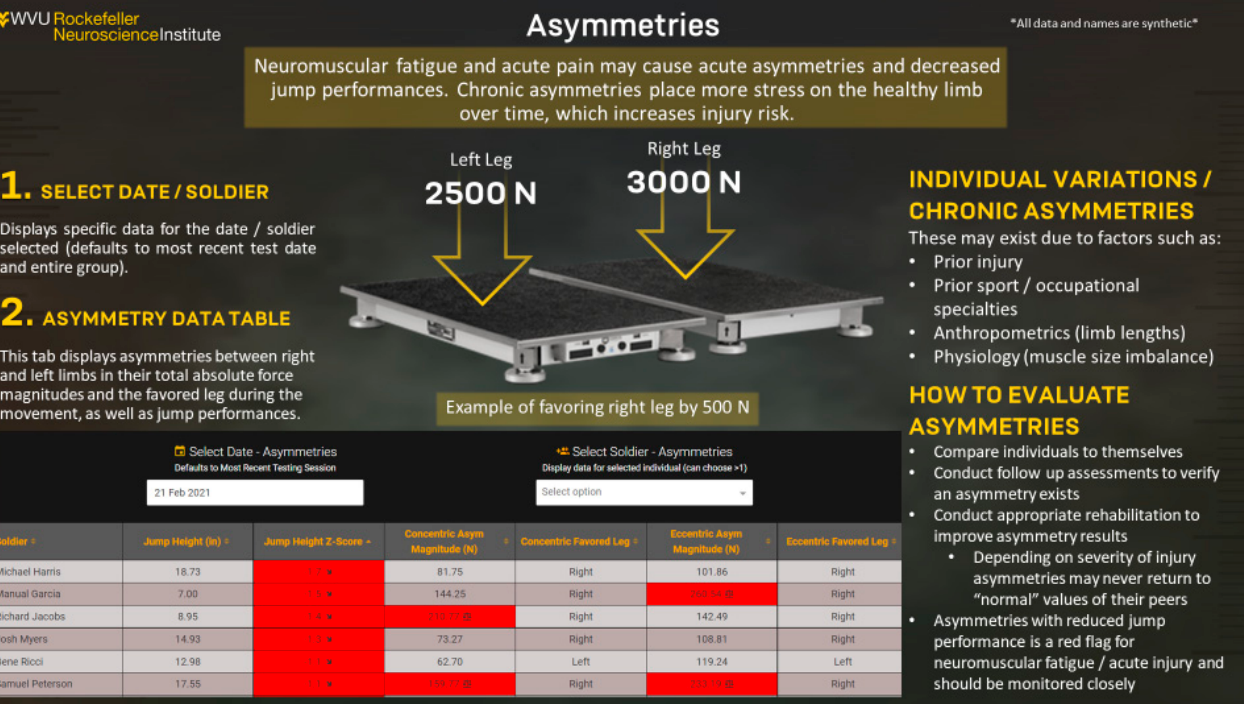
Figure 9. Key concepts and data associated with asymmetry monitoring.